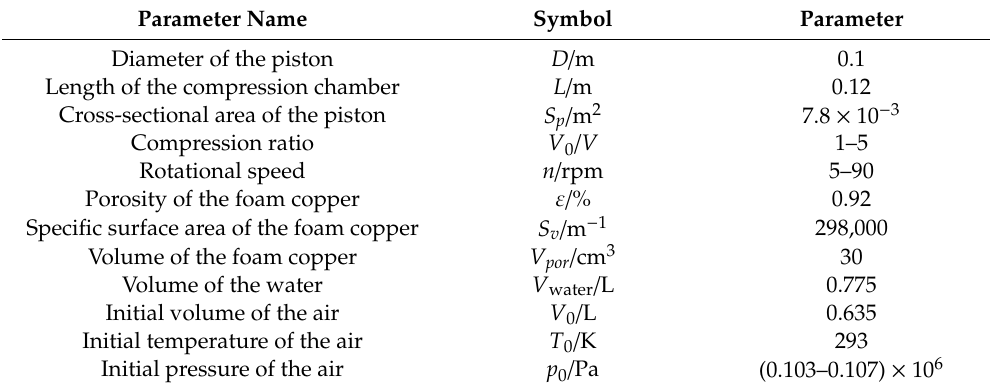
Table 2. Experimental